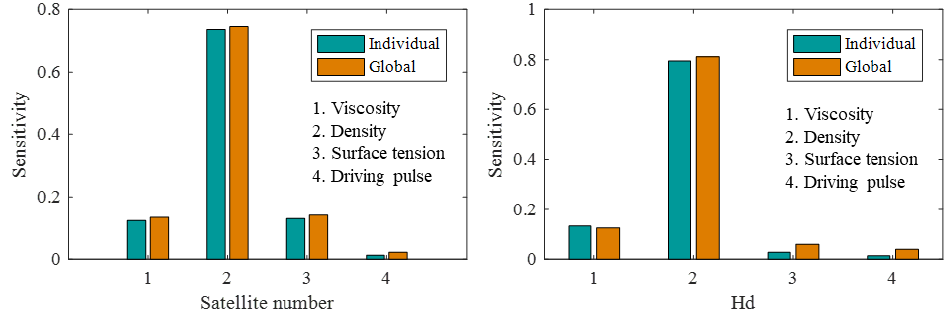
Figure 12. Results of the sensitivity analysis.